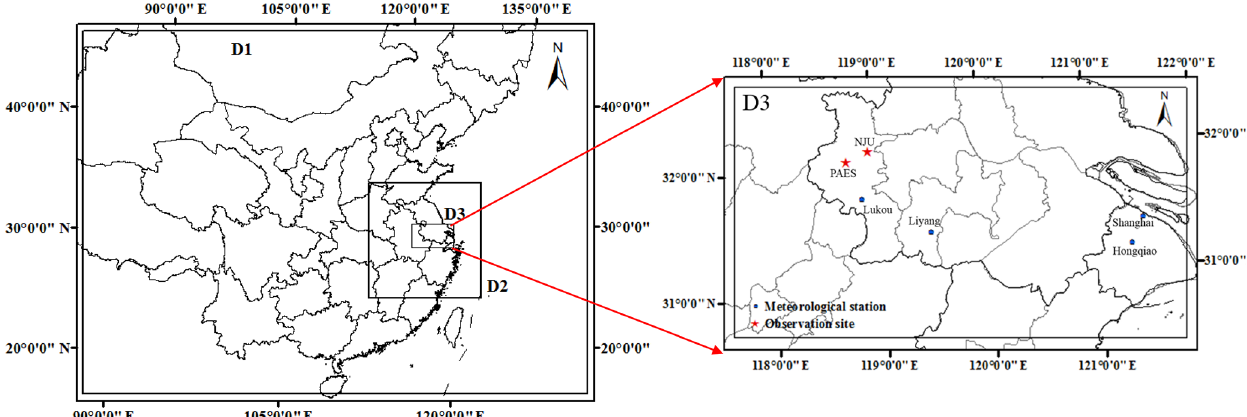
Figure 1. Modeling domain and locations of two observation sites and four meteorological